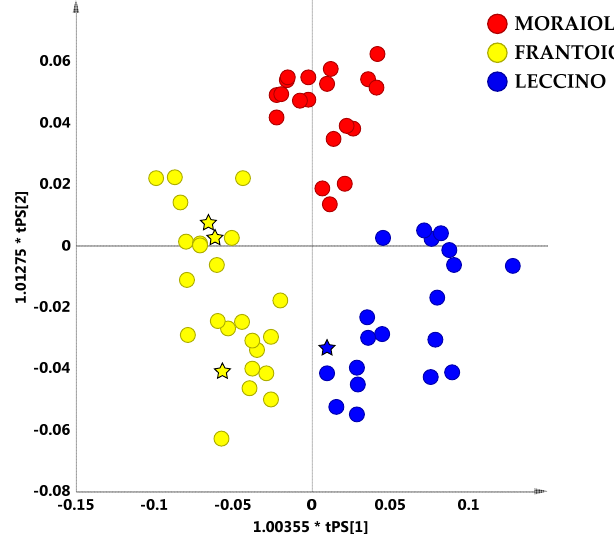
Figure 6. OPLS-DA (2 + 4 + 0 components give R 2 X = 0.83, R 2 Y = 0.74, Q 2 = 0.57) predicted scores plot for main PGI cultivar micro-milled olive oil from the observed compact macro-group. The predicted samples are indicated as five points stars coloured as declared cultivar oils.